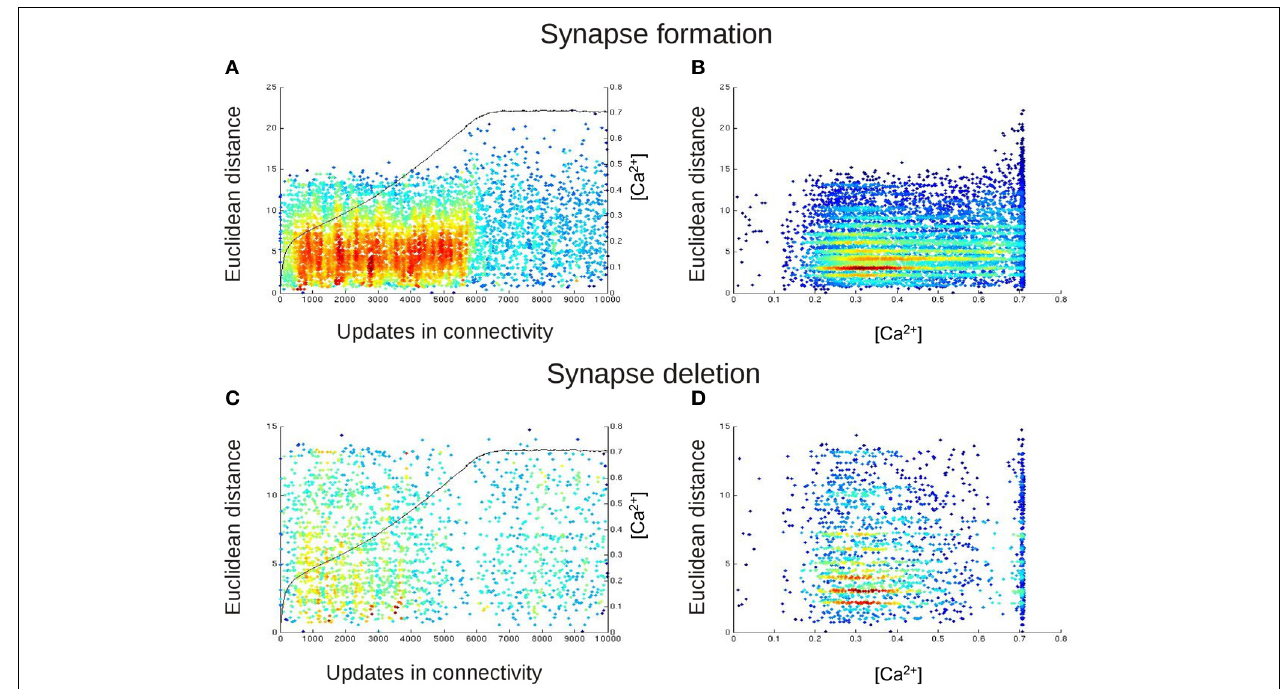
FIGURE 9 | The spatial distribution of newly formed synapses change in dependenceonthecalciumconcentration. In (A,B) ,eachdotrepresentsthe Euclidean distances between those neurons that are most likely to form a synaptic connection with each other at this update in connectivity. For this, we took at every update in connectivity in which vacant synaptic elements were available the Euclidean distance of the connection from neuron j to i for which P form i , j (Equation7)wasmaximal.In (C,D) ,eachdotrepresentsthelengthofthat connection (again in terms of the Euclidean distance between the connected neurons) for which synapse deletion was most likely, i.e., P del i , j (Equation 6) was maximal for every update in connectivity in which synapses had to be deleted. In (A,C) ,weplottedtheEuclideandistancesforsynapseformationanddeletion